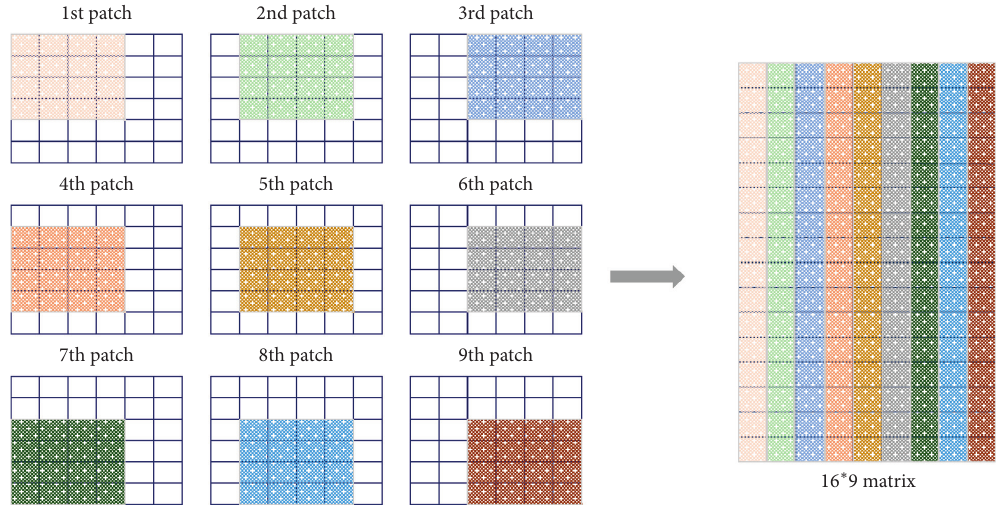
Figure 4: Illustration of 4 × 4 patch size used for 6 × 6